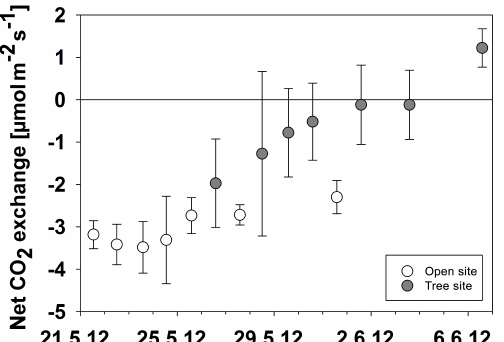
Figure A2. Mean midday net ecosystem exchange (NEE) of the understorey vegetation at the open site (white circles) and the tree site (dark grey